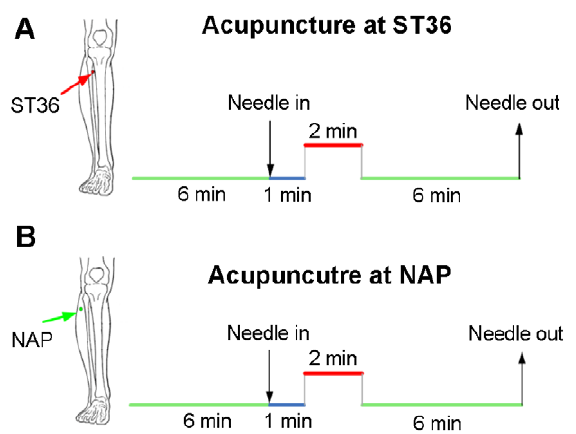
Figure 1. Experimental paradigm. Panel A indicates that acupunc- ture stimulation was performed at acupoint ST36 on the right leg (Zusanli, arrow pointing to the red dot). Panel B indicates that needling was performed at an adjacent nonacupoint on the right leg (NAP, arrow pointing to the green dot). The red line refers to needle administration, and the blue line represents no acupuncture manipulation but with needles inserted, while the green long line indicates a 6 min resting state or post-stimulus resting state. In this study, the two 6 min resting epochs were employed, while the rest were used for further analysis.